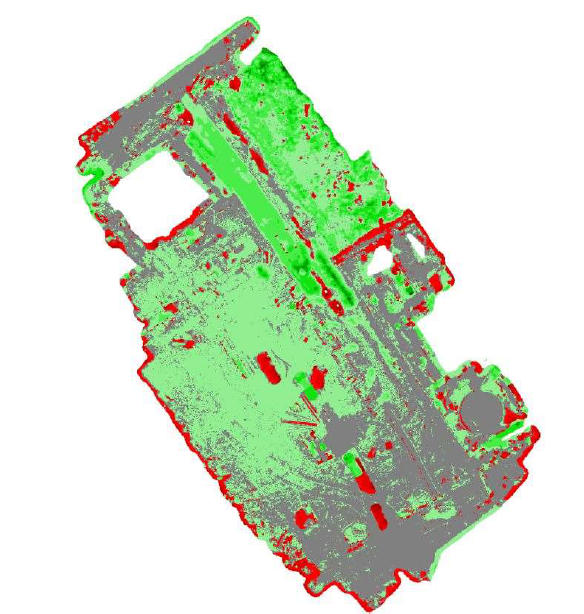
Figure 10: The volume calculation displayed with a fill, cut and a total calculation in numbers.